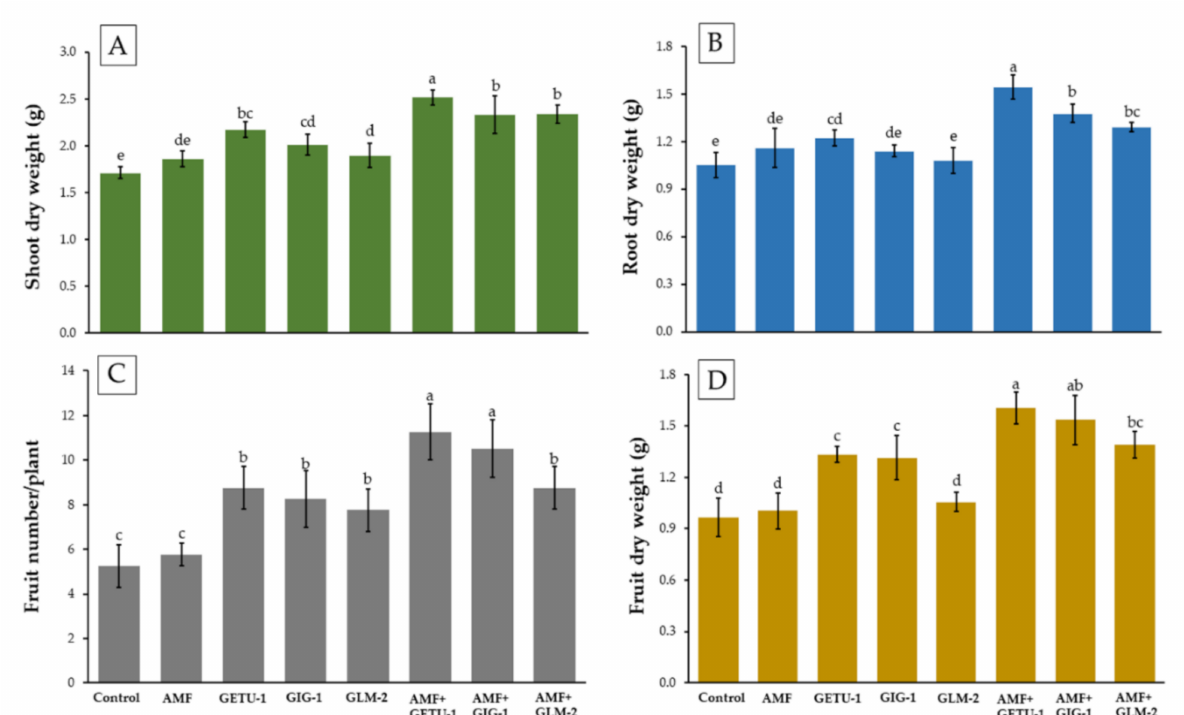
Figure 6. Shoot dry weight ( A ), root dry weight ( B ), fruit number per plant ( C ), and fruit dry weight per plant ( D ) of chili plants in each treatment at 180 days. The means with the standard deviation bar are shown in each graph. Different letters above each graph in the same experiment indicate that the means are significantly different by DMRT ( p <